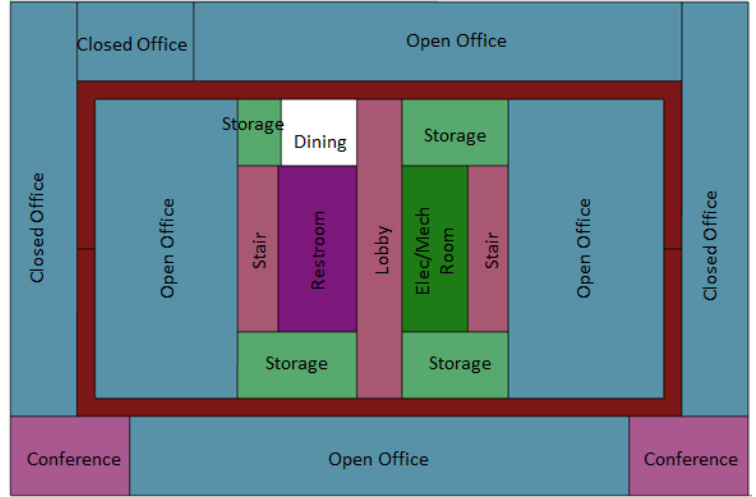
Figure 1. Floor plan and geometry of the DOE medium office 90.1-2007 prototype model with detailed zoning.